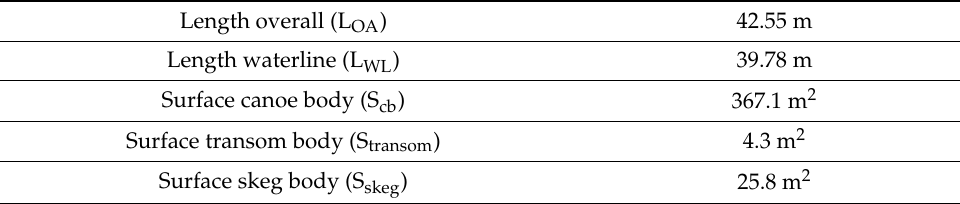
Table 2. Geometrical features of the superyacht elected as a case study.